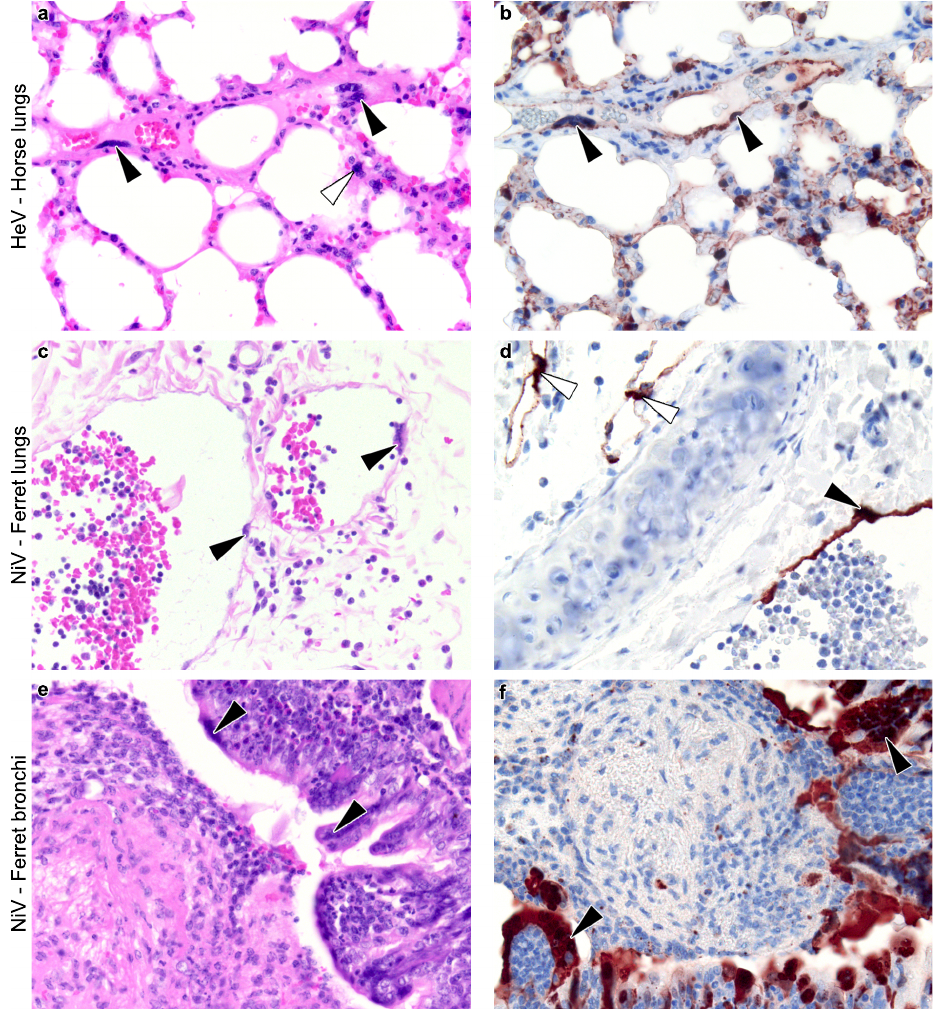
Figure 3. Henipavirus-induced syncytia in vivo. ( a – f ) Histological sections of lungs of animals exper- imentally infected with henipaviruses. Slides were stained with haematoxylin and eosin ( a , c , e ) and by immunohistochemistry for henipavirus nucleoprotein antigen ( b , d , f ) (brown color). Horse lungs ( a , b , magnification x40) show syncytia of the blood vessel endothelium (black arrowheads) and associated with the alveolar walls (white arrowhead). Ferret lungs ( c , d , magnification x20) show syncytia of the blood vessel endothelium (black arrowheads); in these images, the endothelium has fused with attenuation and sloughing, leaving regions of the vessel wall denuded. Virus has also infected the endothelium of lymphatic vessels (white arrowheads). Ferret bronchi ( e , f , magnification x20) show syncytia of the bronchial epithelium (black arrowheads), some of which form into stalked structures; in these images, the bronchus is filled with inflammatory and cellular debris, transferred from elsewhere in the airways. These pictures were prepared specifically for this review from material taken from past studies (( a , b ) [90]; ( c , f )